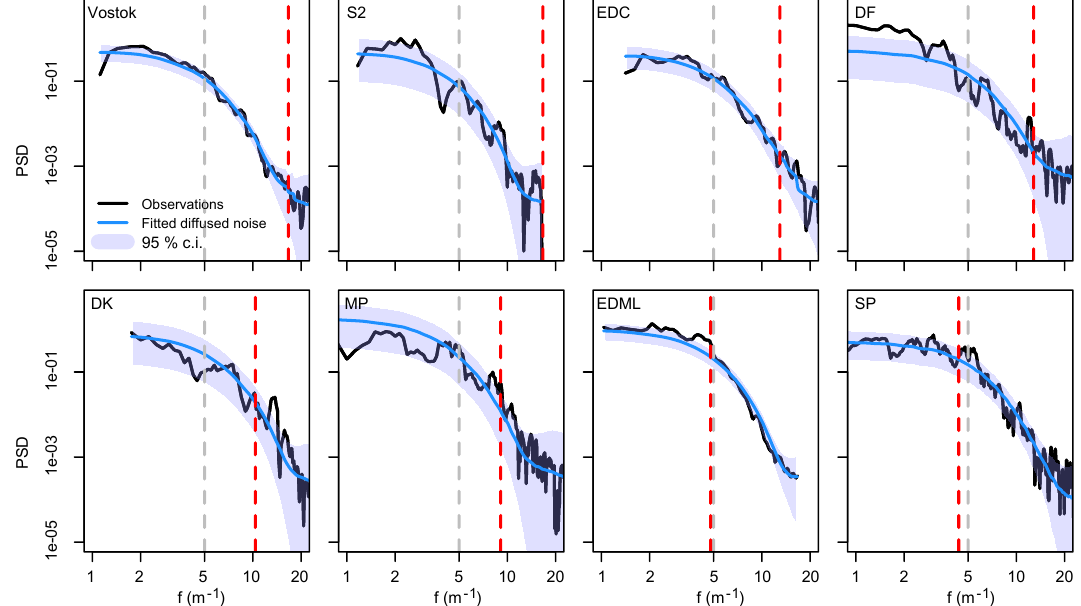
Figure 4. Power spectra of the firn δ 18 O variations in the firn profiles. The null hypothesis of diffused white noise (blue) and the corre- sponding critical significance threshold values (shaded blue) are shown. For each site, the frequency corresponding to the annual snow layer thickness is shown as a vertical red dashed line, and the frequency corresponding to 20cm is shown as a vertical grey dashed